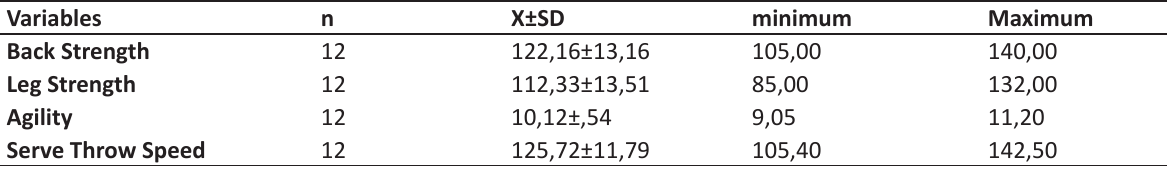
Table 3. The correlation analysis between the serve throw speed and other variables Variables